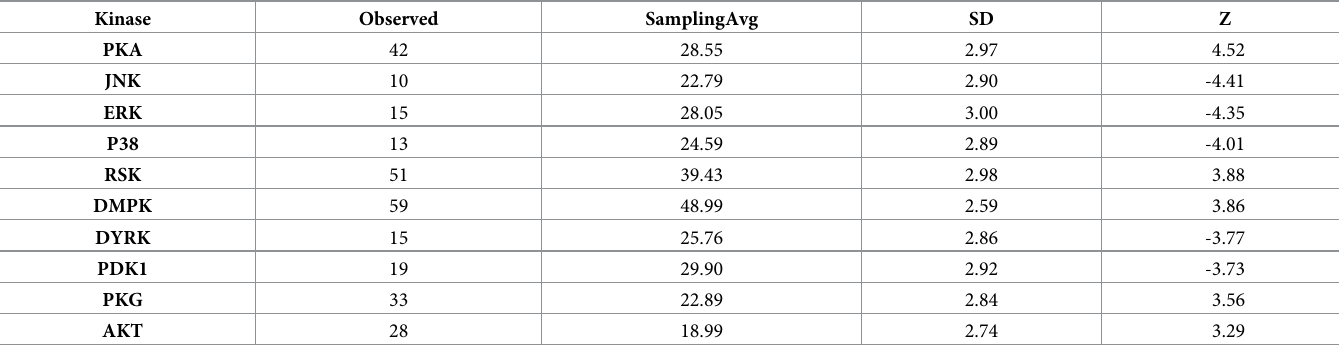
Table 2. Predicted kinases and distributions for female vs. male (HPC).